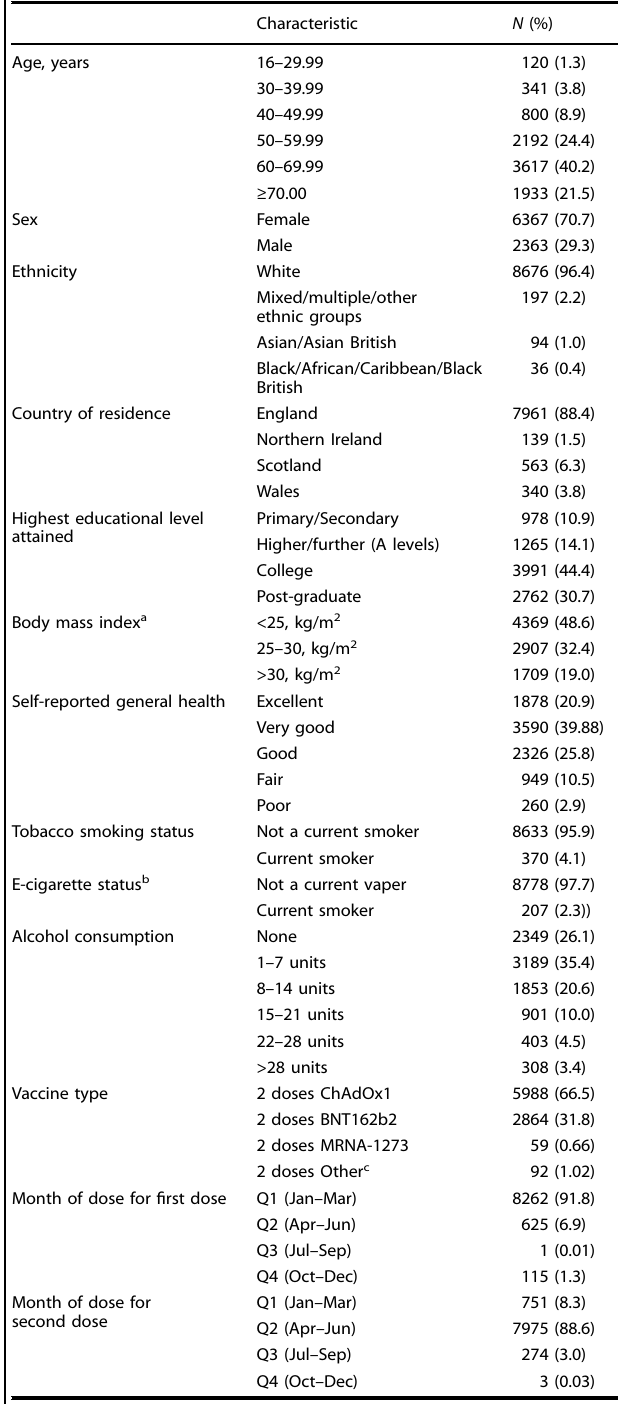
a Body mass index missing for 18 participants. b Vape status missing for 18 participants.